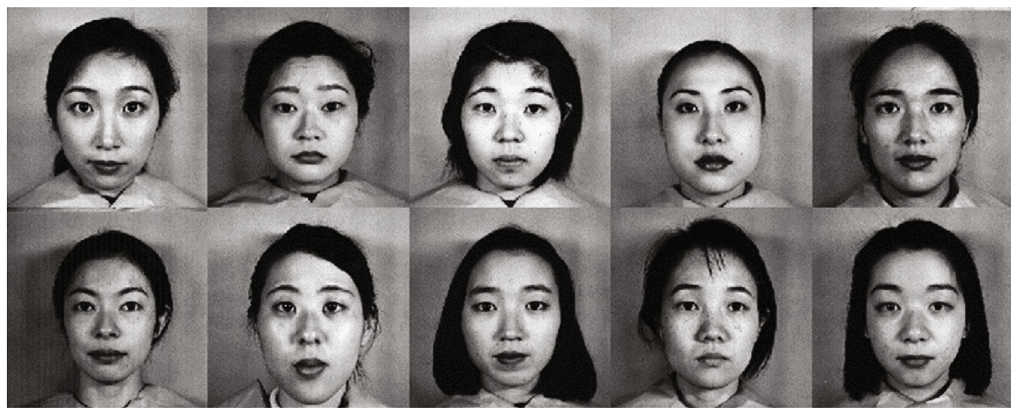
Figure 2: Subjects in the JAFFE